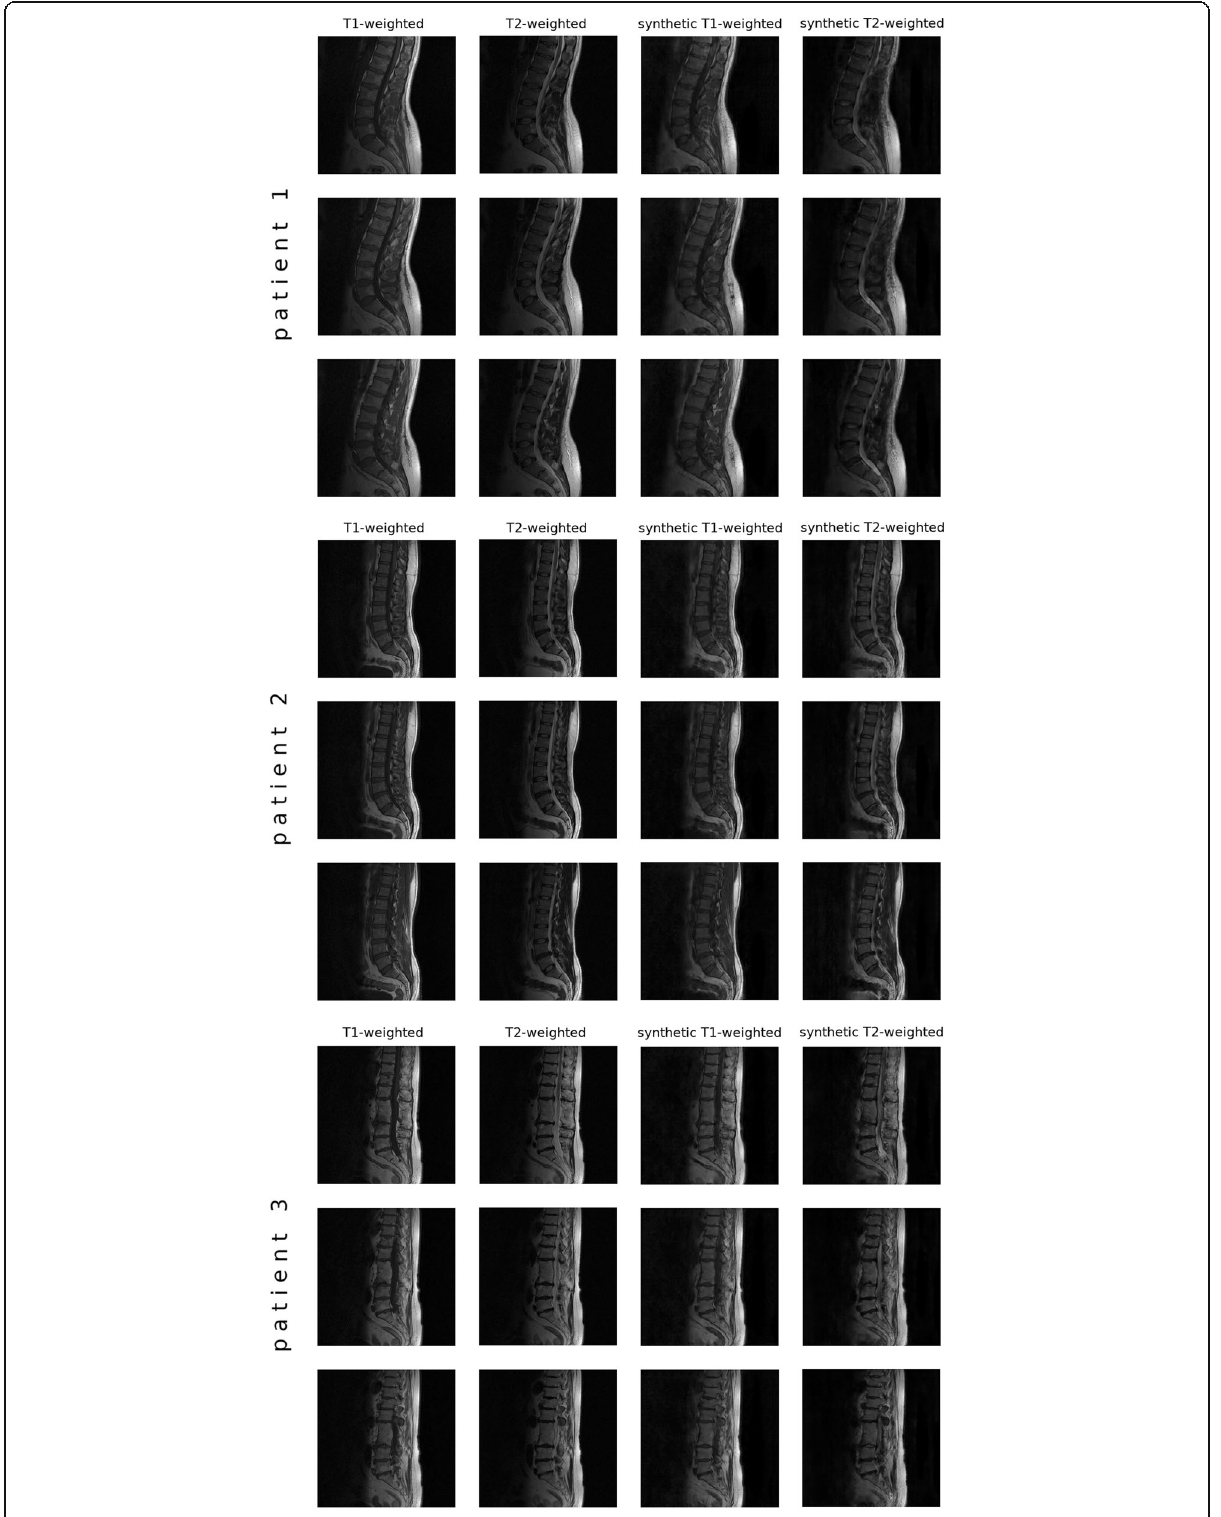
Fig. 4 Representative results (three slices for three different patients) of the translation from T1W to T2W MRI and vice versa. In the first patient, Type II Modic changes were correctly represented in both synthetic images, whereas for the Type I change in the third patient the synthetic T2W image showed a low signal instead of a high one. The L4-L5 disc protrusion of the second patient was accurately represented in the synthetic T2W